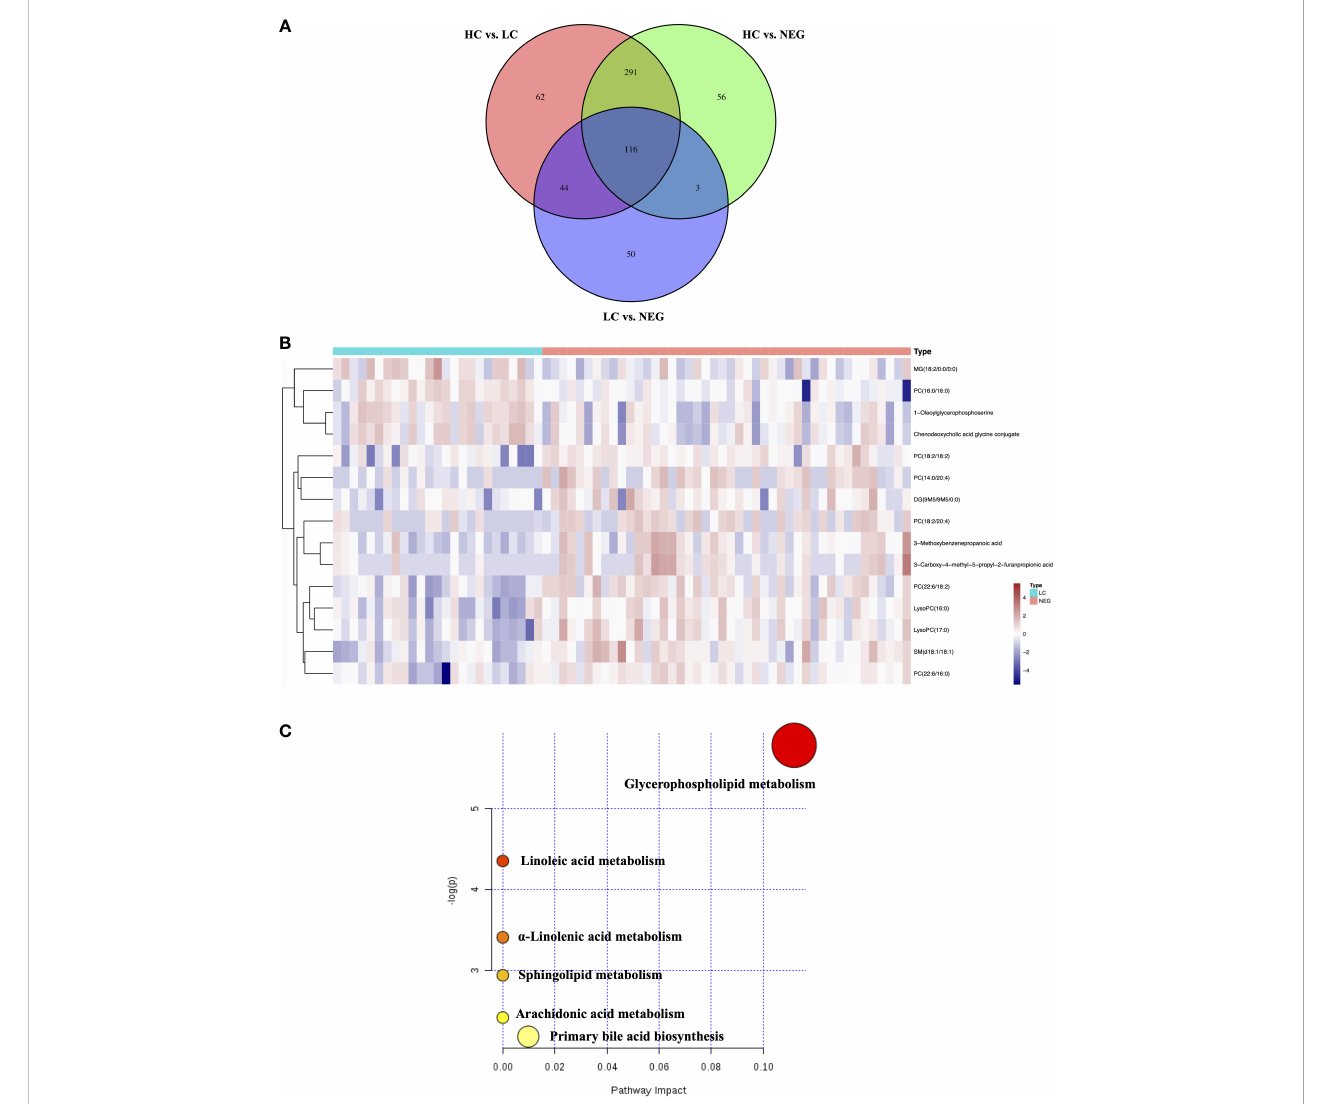
FIGURE 2 Differential metabolites for AFP negative HCC. (A) Venn diagram of the differential ions in HC vs. LC, HC vs. NEG and LC vs. NEG. (B) Heatmap of 15 differentially expressed metabolites between LC and NEG group according to the normalized intensity. (C) Summary of altered pathways AFP negative HCC patients compared to liver cirrhosis patients, as analyzed by MetaboAnalyst platform (https://www.metaboanalyst.ca/).